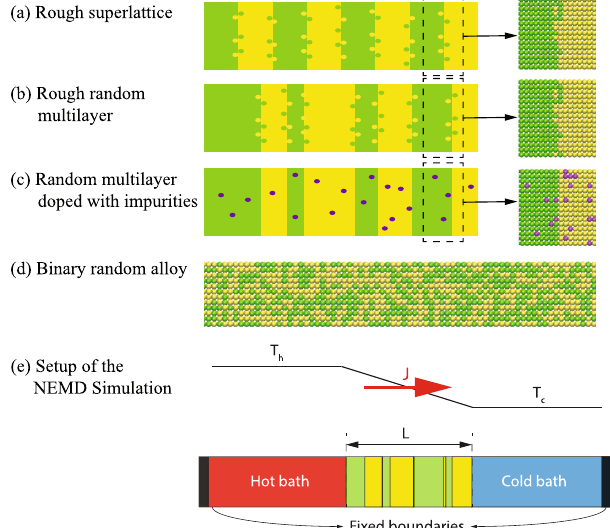
Figure 1. Schematic of the structures simulated in this work and the corresponding atomic structure: ( a ) rough superlattice; ( b ) rough random multilayer; ( c ) random multilayer doped with impurities; ( d ) binary random alloy. ( e ) shows the setup of the NEMD